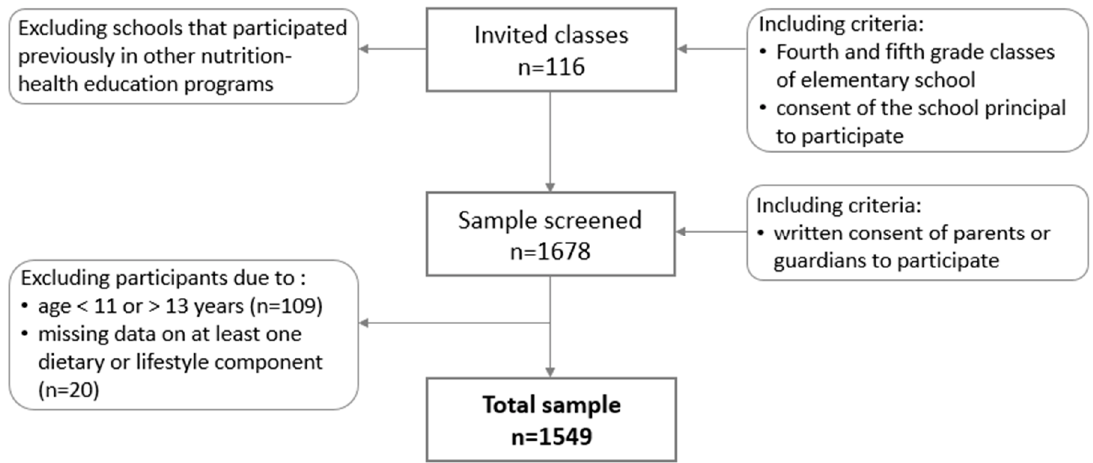
Figure 1. Sample